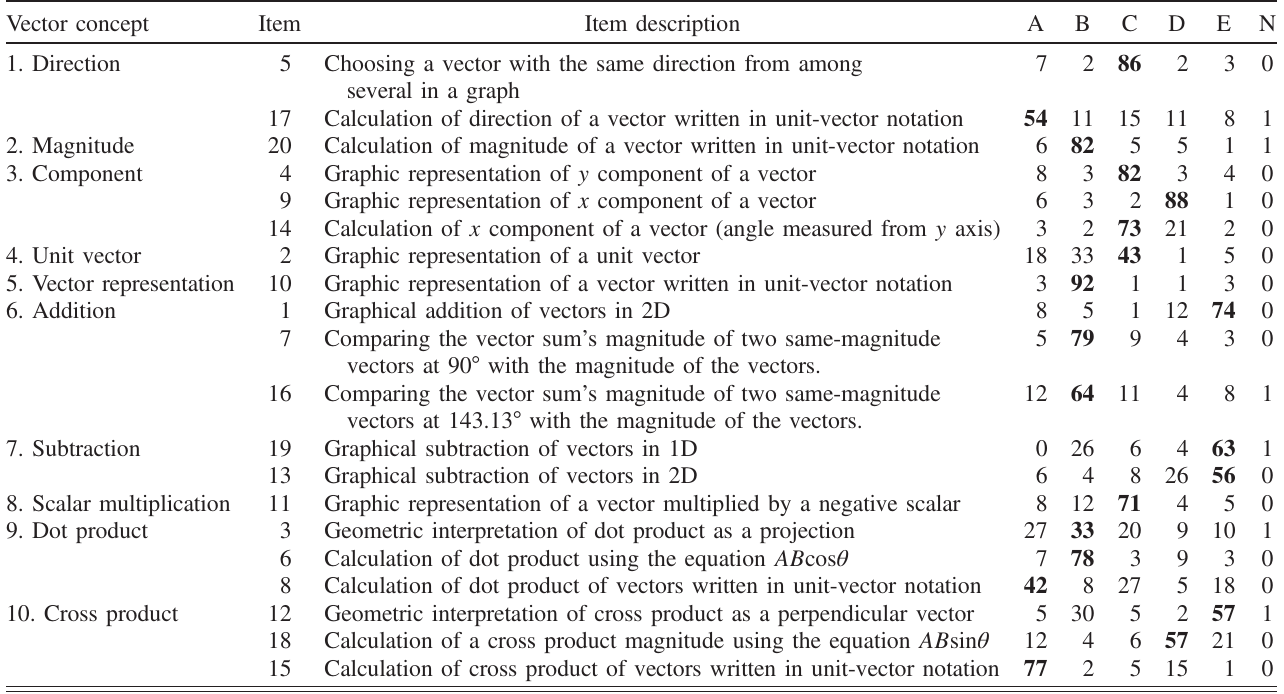
TABLE IV. The 10 vector concepts evaluated in the TUV, the description of the items, and the percentages of the 423 students of E&M selecting a particular choice for each item. The correct answer is in boldface and N is for students that did not answer. Vector concept